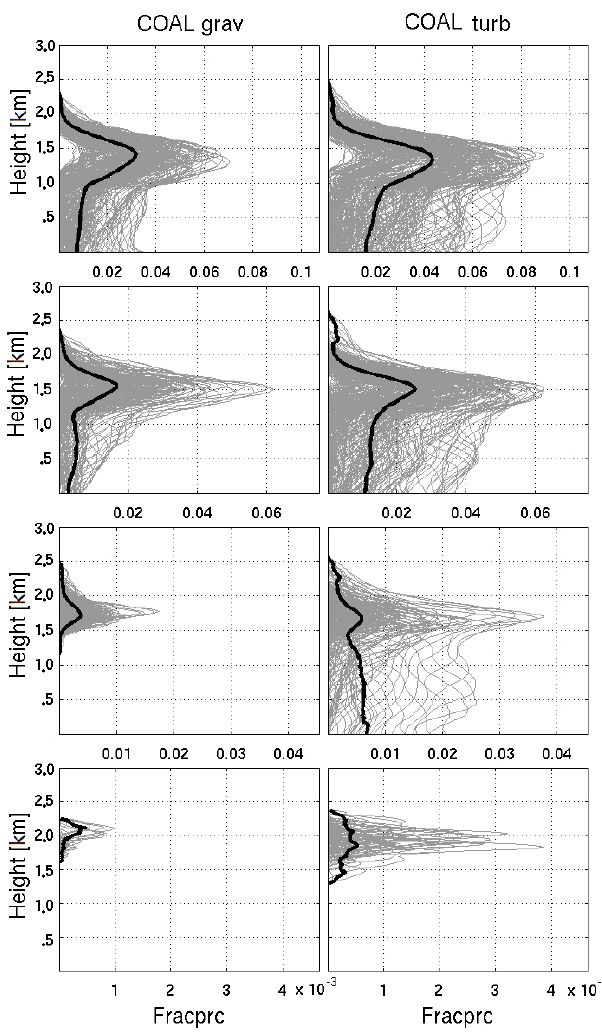
Fig. 11. Profiles of the precipitation fraction (Fracprc) for simula- tions with (left column) gravitational kernel and (right column) tur- bulent kernel, and for simulations (top to bottom) N 30, N 60, N 120, and N 240. Grey lines represent evolution of 1min average profiles between hours 1 and 6; black thick line is the average of the grey profiles.